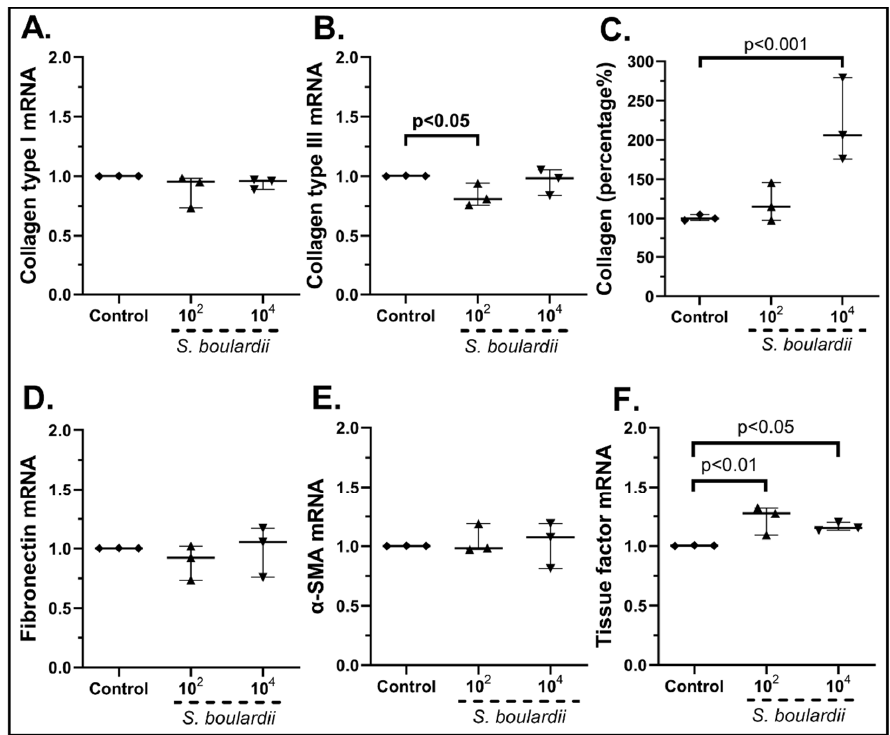
Figure 9. cSEMF mRNA expression of Collagen Type I ( A ), Collagen Type III ( B ), Fibronectin ( D ), α-SMA ( E ), Tissue factor ( F ) and Collagen secretion ( C ) after stimulation with Saccharomyces boulardii. Results are presented as median with interquartile range. N = 3. Bifidobacterium lactis added alone (Figure 10) reduced the cSEMF mRNA of Collagen Type ΙΙΙ (10 2 cfu/mL: 0.76-fold, IQR: 0.58–0.90, p < 0.05; 10 4 cfu/mL: 0.70-fold, IQR: 0.67– 0.76, p < 0.01, Figure 10B), but had no effect on Collagen Type I mRNA (Figure 10A) or its total protein production (Figure 10C). Similarly, the addition of the highest dose resulted in the downregulation of Fibronectin (10 4 cfu/mL: 0.65-fold, IQR: 0.62–0.88, p < 0.01, Figure 10D), while none of the two doses had any effect on α-SMA (Figure 10E) and Tissue Factor (Figure 10F) mRNA expression.